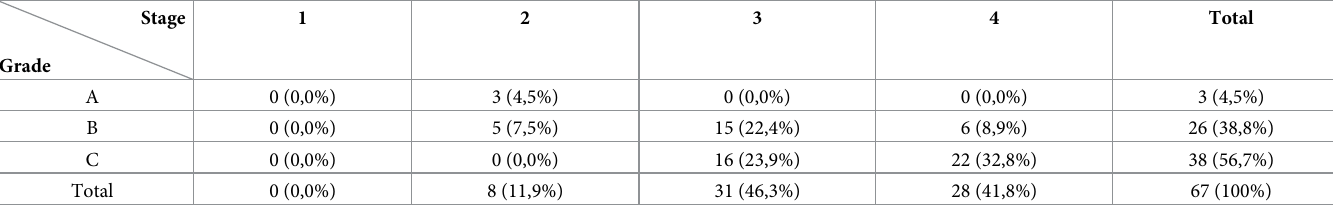
On the basis of protein profiles obtained by MALDI-TOF MS, a diagnostic decision tree for periodontitis based on the differentially expressed peaks was made for each type of sample (Fig 2). For saliva, 7 peaks were selected to build a diagnostic decision tree with a sensitivity = 98% and a specificity = 91%. For GCF and dental plaque, 9 peaks were selected to build a diagnostic decision tree with a sensitivity = 96% and 94% and a specificity = 98% and 96%, respectively. In the blind experiment with a 10-fold cross-validation, diagnostic decision trees were con- firmed with a sensitivity = 70.3% ( ± 0.211) and a specificity = 77.8% ( ± 0.165) for saliva, a sen- sitivity = 79.6% ( ± 0.188) and a specificity = 75.7% ( ± 0.195) for GCF, and a sensitivity = 72.1% ( ± 0.202) and a specificity = 72.2% ( ± 0.195) for dental plaque. When a concatenation of the 3 decision trees was performed with a minimum of two sam- ples tested, we found a sensitivity = 1 (CI 95% = [0.91;1]), a specificity = 1 (CI 95% = [0.92;1]), Table 2. Stages and grades in the periodontitis group according to the Chicago classification [1]. The percentage in each box refers to the relative frequency in relation to the total of 67 periodontitis